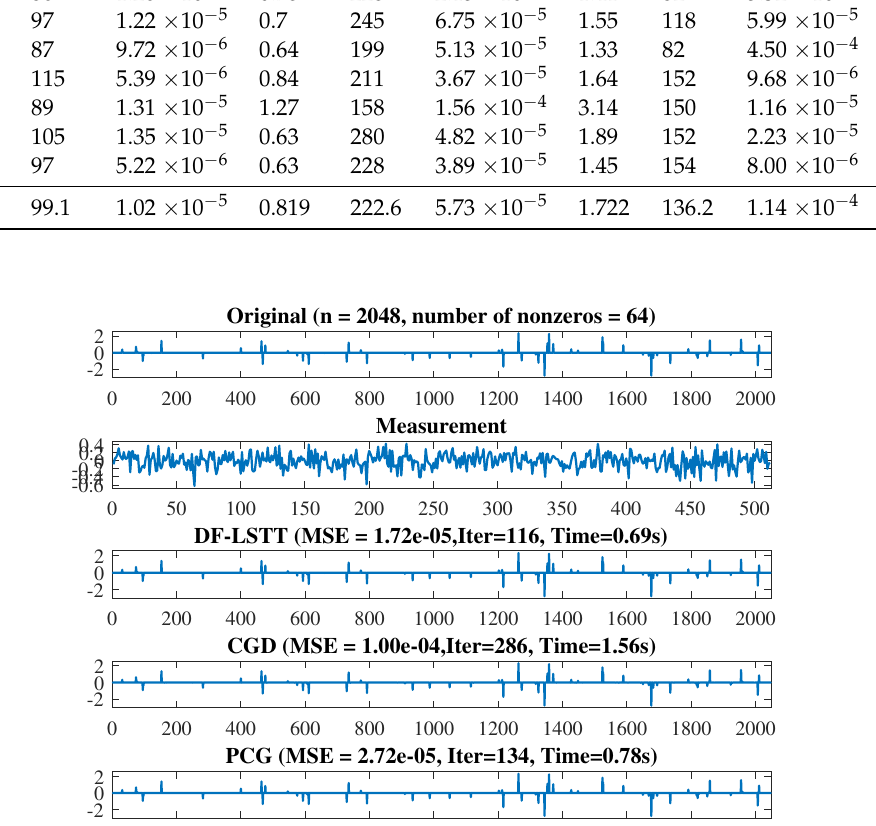
Figure 1. Illustration of the sparse signal recovery. From the top to the bottom is the original signal ( First plot ), the measurement ( Second plot ), and the reconstructed signals by DF-LSTT ( Third plot ), CGD ( Fourth plot ), and PCG ( Fifth plot